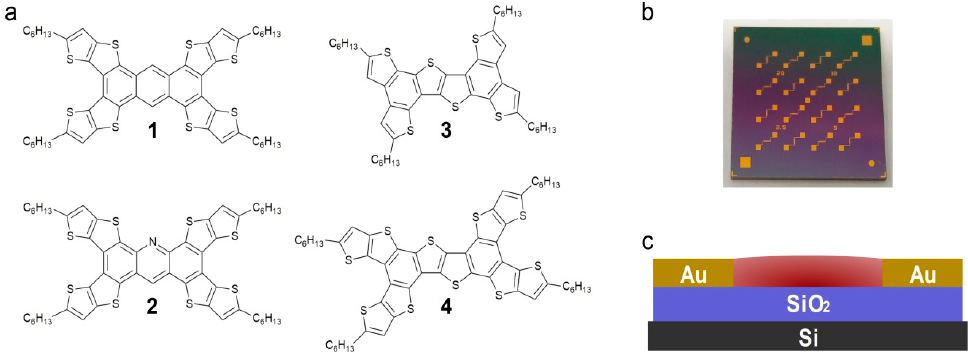
Figure 1. ( a ) molecular structure of the 2D thienoacenes investigated, ( b ) photo of a Fraunhofer chip (City, US State abbrev. if applicable, Country) used and ( c ) the bottom-gate bottom-contact (BGBC) OTFT architecture of the devices on the chip. Bottom-gate bottom-contact (BGBC) OTFTs (Figure 1b,c) were constructed using pre-fabricated